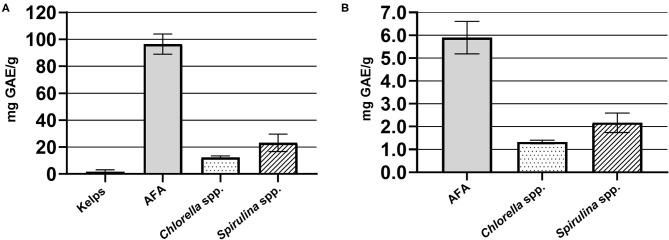
(A) Average total phenolic compounds (Folin–Ciocalteu method); (B) average antioxidative potential values (DPPH method) in different types of algae-based dietary supplement samples, expressed as mg gallic acid equivalent (GAE)/g solid sample.